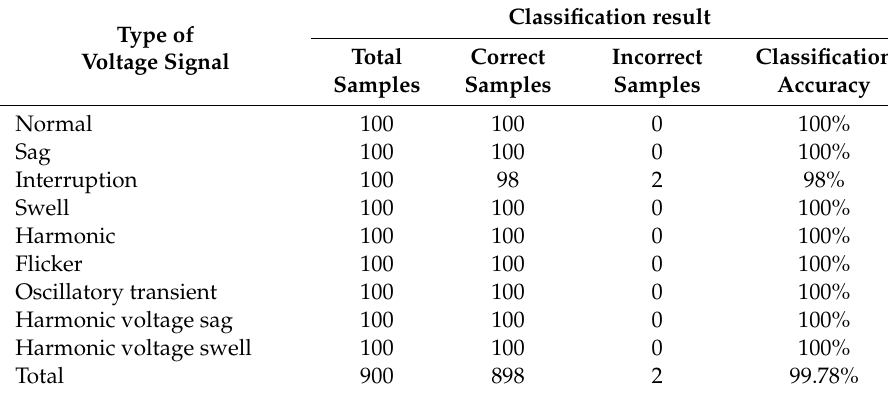
Table 2. Classification results of PQ